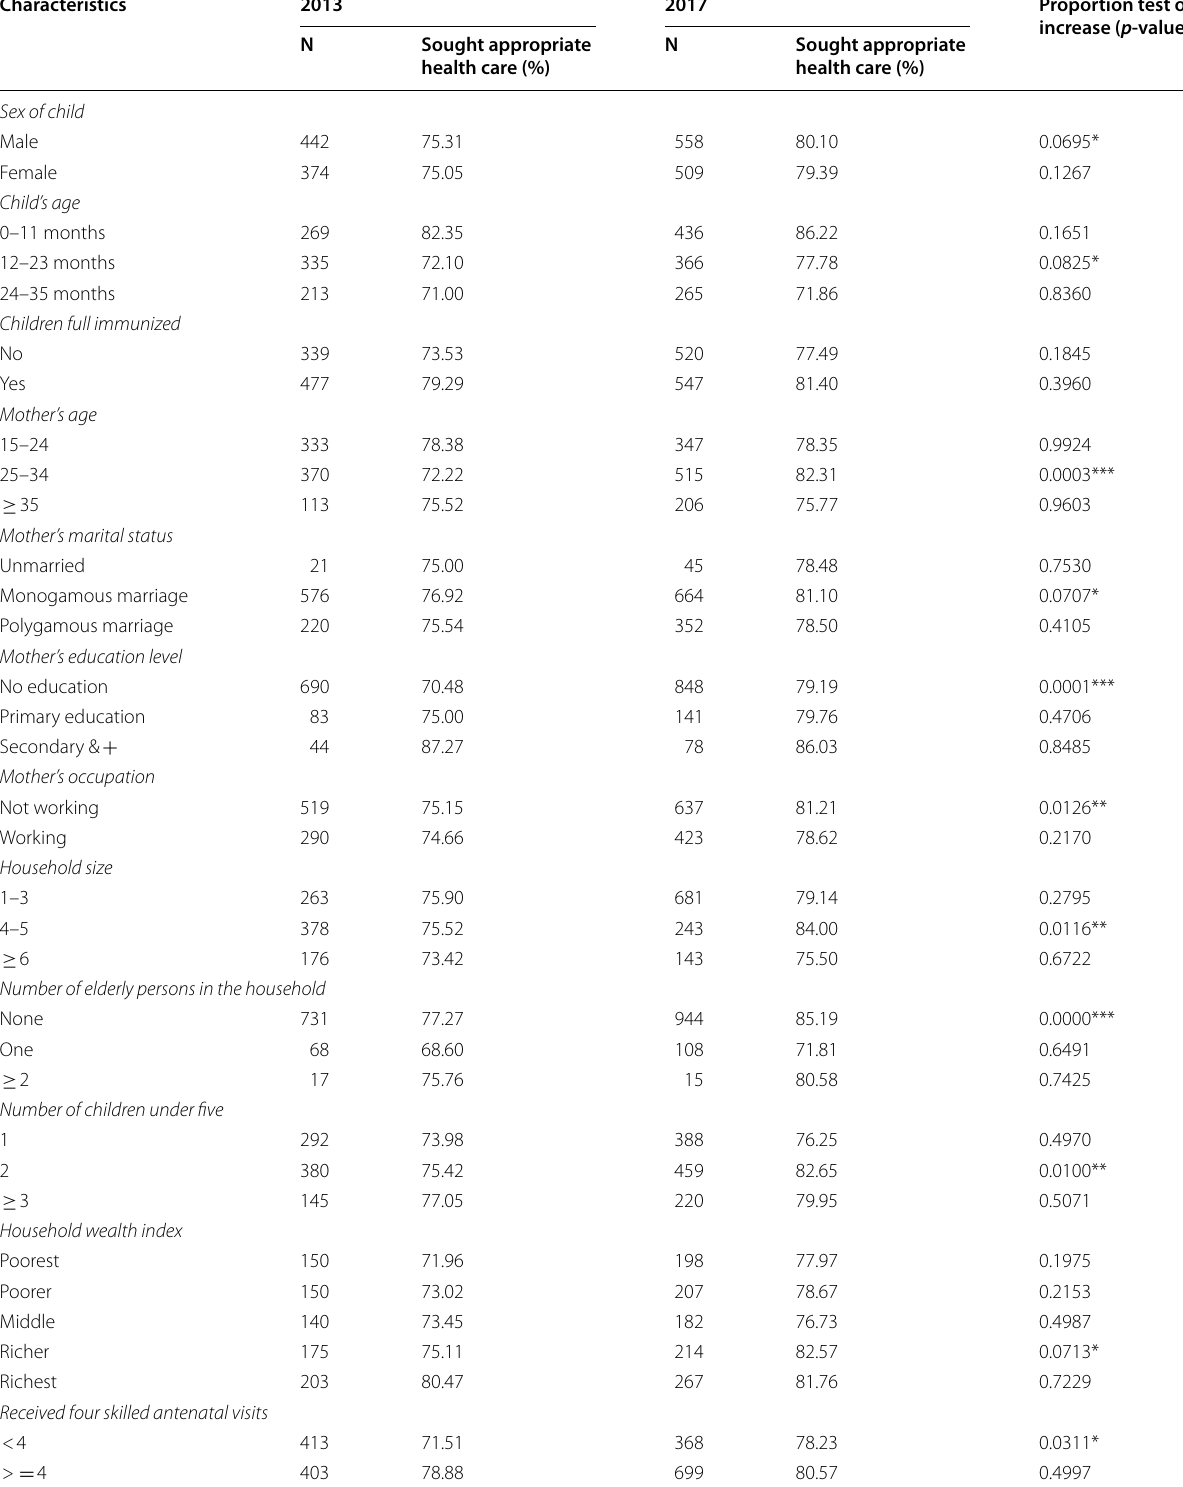
Table 2 Descriptive results of healthcare utilization for fever among child, maternal, household and health facility-level characteristics from the baseline (2013) and endline (2017) survey data for the impact evaluation of Performance-Based Financing (PBF) in Burkina